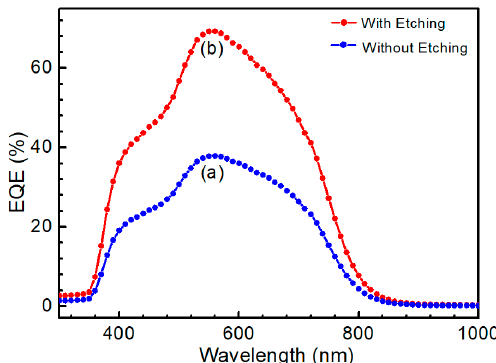
ffi ciency of CZTS solar cells ( a ) without etching ( b ) etching for 10 Figure 12. Quantum efficiency of CZTS solar cells ( a ) without etching ( b ) etching for 10 min. Figure 12. Quantum e